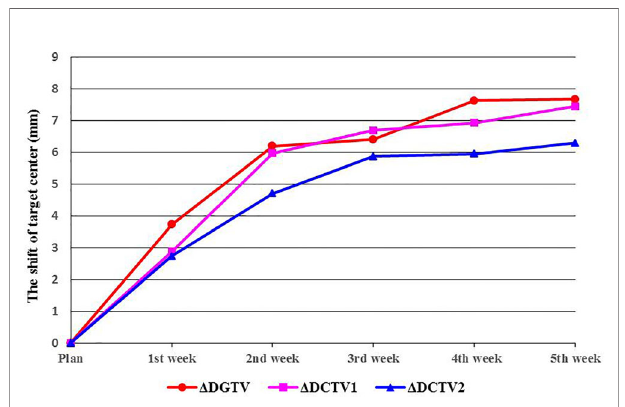
FIGURE 3 | Shifts in target center. D DGTV, D DCTV1, and D DCTV2 represent displacements of the GTV, CTV1, and CTV2 centers, respectively.